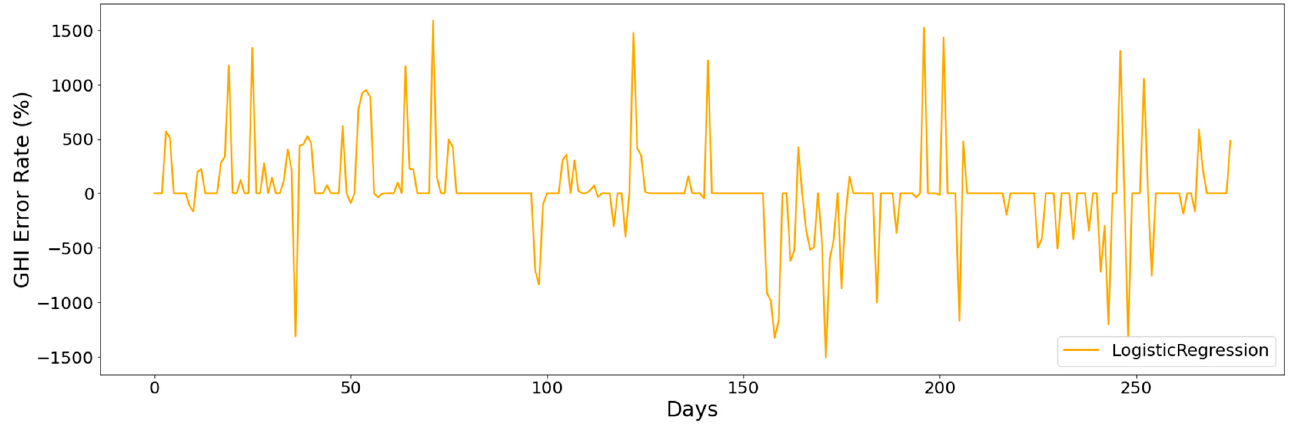
Figure 11. Graphical representation of SVM predictions.